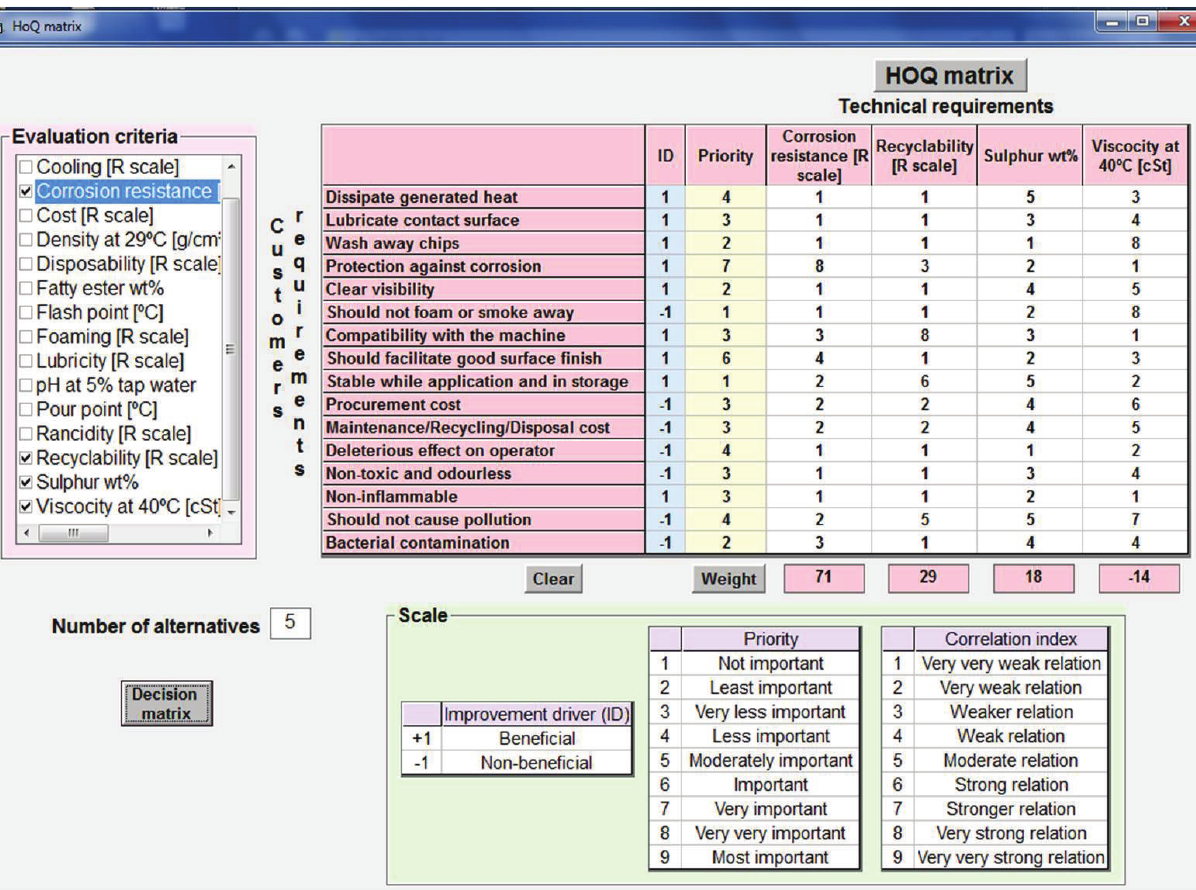
Figure 7: HOQ matrix for Example